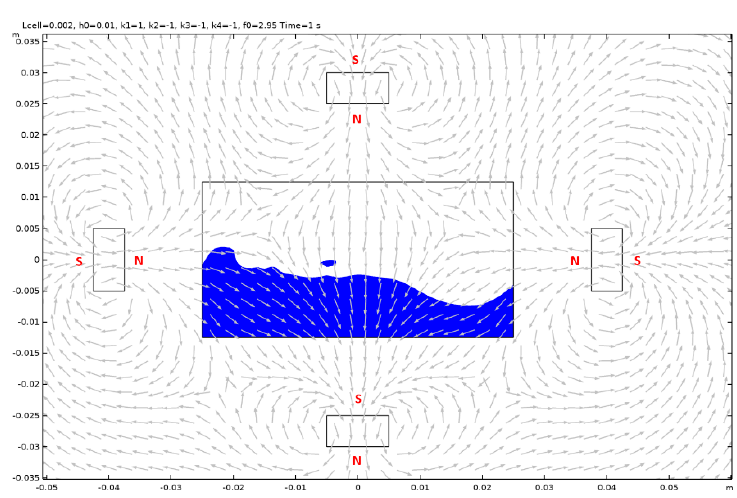
Figure A23. Case 9. Figure A23. Case 9.